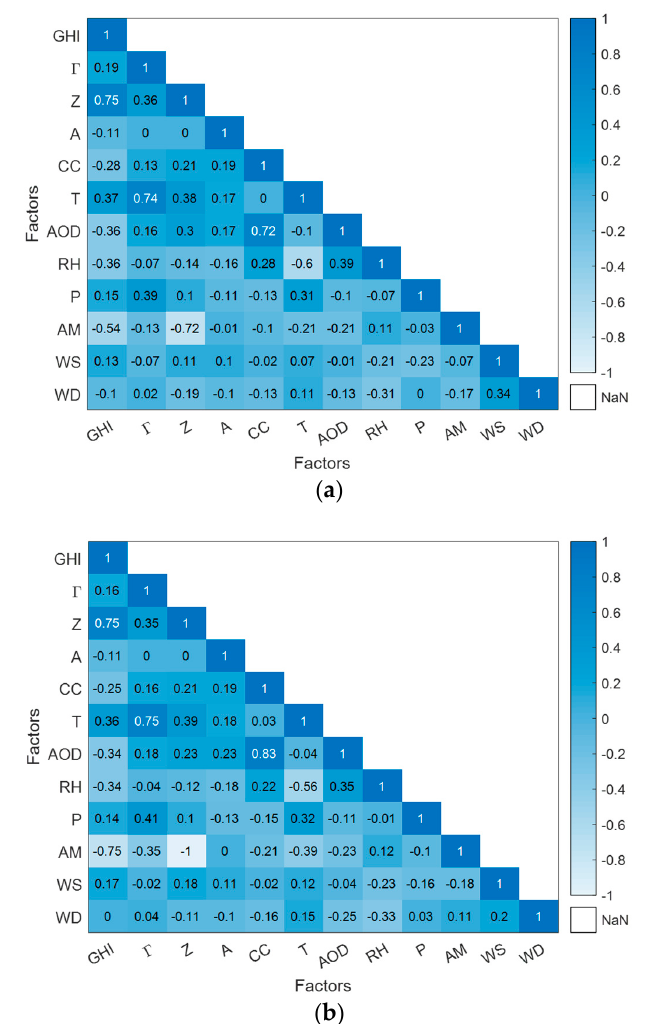
Figure 3. Correlation coefficients for every two different variables. Z is the cosine function of the solar zenith angle, A is the solar azimuth angle, CC is cloud cover, T is temperature, AOD is aerosol optical depth, RH is relative humidity, P is station pressure, AM is airmass, WS is wind speed, and WD is wind direction. ( a ) Pearson correlation coefficient. ( b ) Spearman’s rank correlation coefficient.